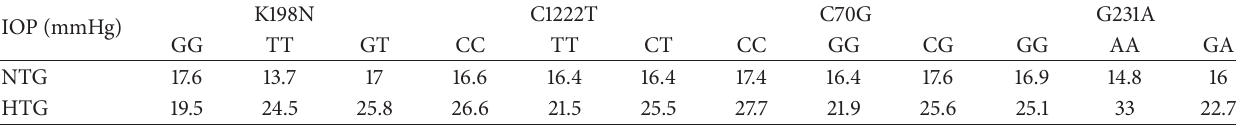
Table 7: Maximum intraocular pressure (IOP) according to the allelic variants of studied polymorphisms. IOP (mmHg) NTG